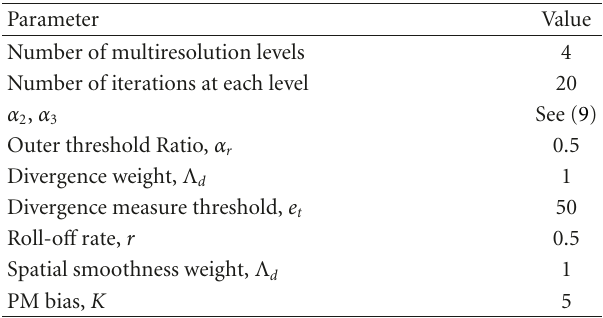
Table 3: The experimental parameter values for the algorithm. Parameter Value